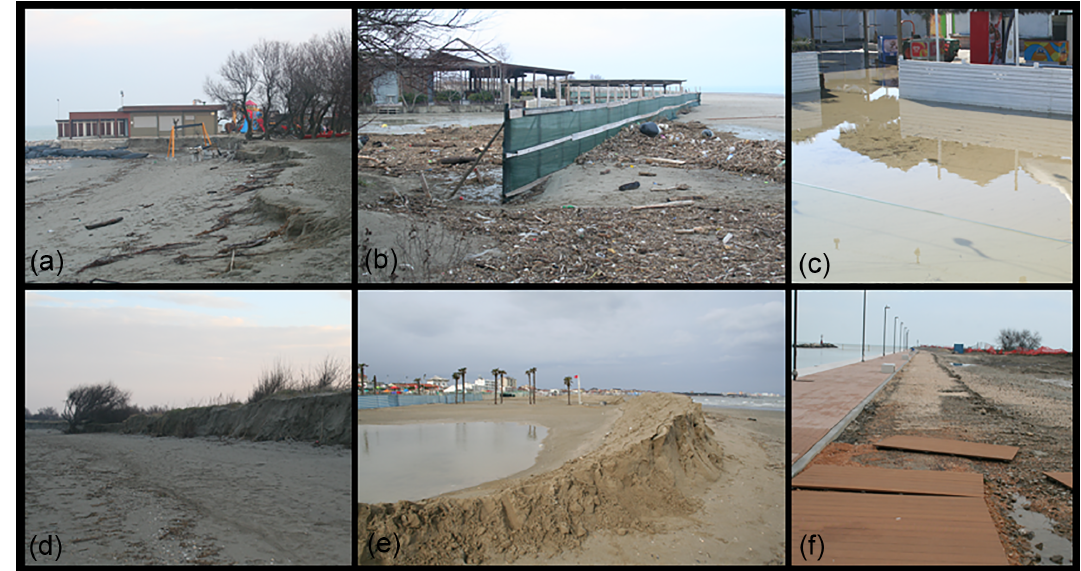
Figure 3. Impacts of the event in February 2015 on the Lido degli Estensi–Spina case study area. Impacts of erosion and flooding on concessions at Lido di Spina south (a, b) and Lido degli Estensi (c) ; sandy scarp due to the erosion of the dune in the south of Lido di Spina (d) ; eroded winter dune in Porto Garibaldi (e) ; damages to the Porto Canale front at the Lido degli Estensi (f)